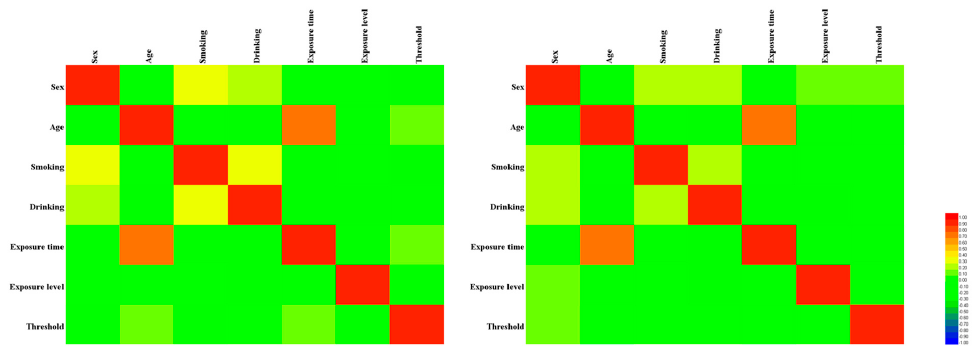
Figure 1. Heatmap based on the correlation between factors such as sex, age, smoking, drinking, exposure time, exposure level, and threshold shift. The left is the case group and the right is the control group.